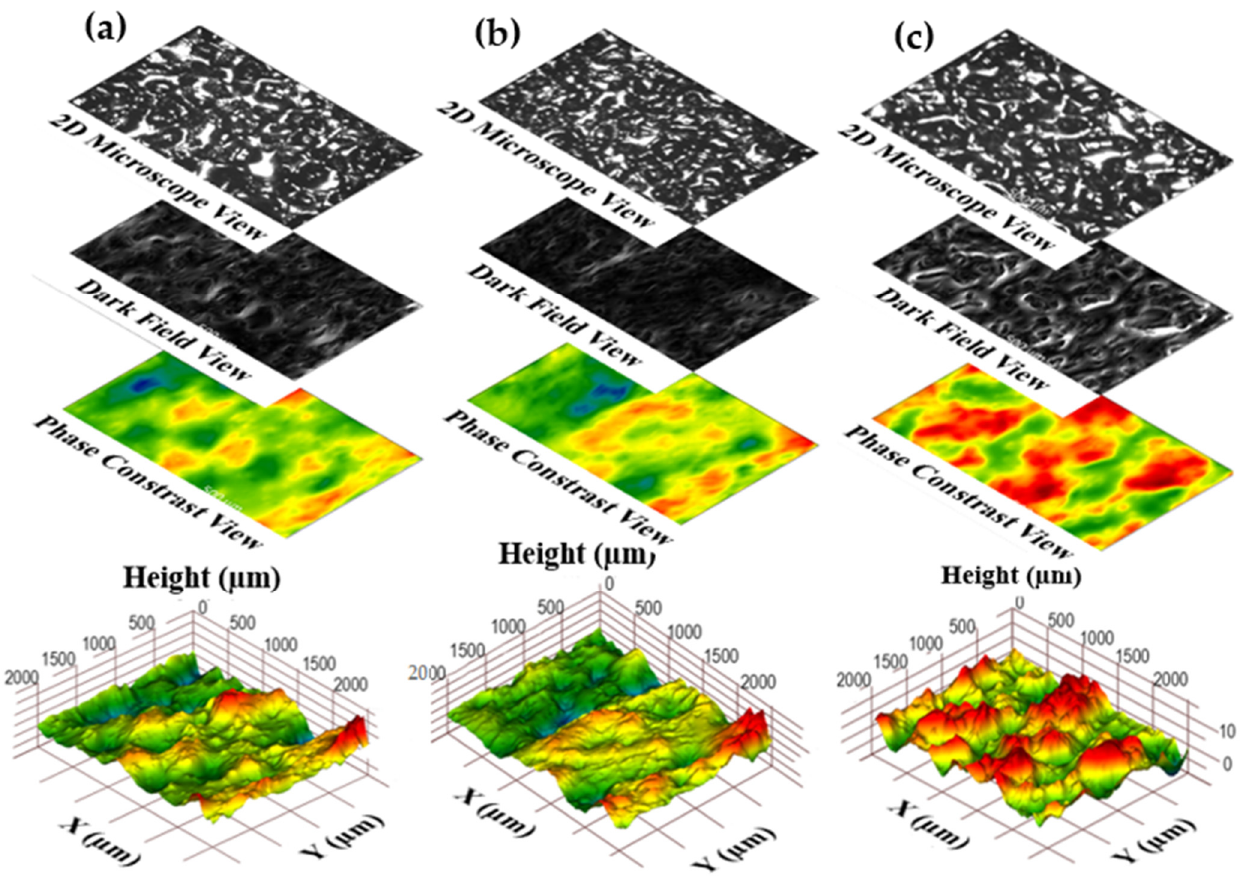
Figure 4. Surface images of the samples: ( a ) UT (500 μ s-6 A), ( b ) SCT (300 μ s-6 A), ( c ) DCT (500 μ s- 6